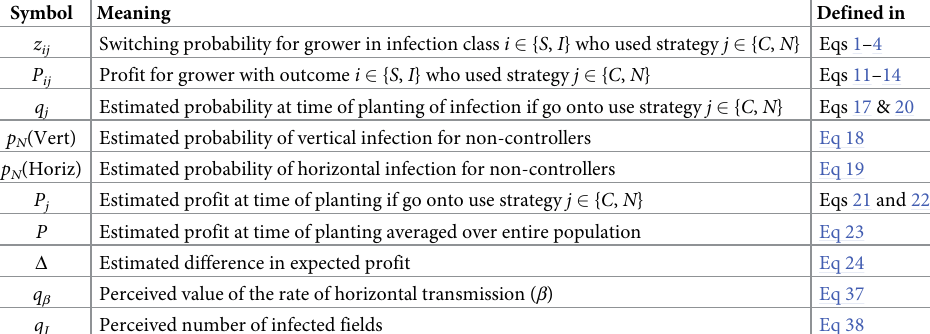
Table 3. Summary of symbols used in defining the behavioural models. The outcomes i 2 { S , I } represent—at the end of the season—fields that are (S)usceptible and (I)nfected, respectively. The strategies j 2 { C , N } correspond to (C) ontrollers (i.e. use clean seed) and (N)on-controllers (i.e. do not use clean seed), respectively. Symbol